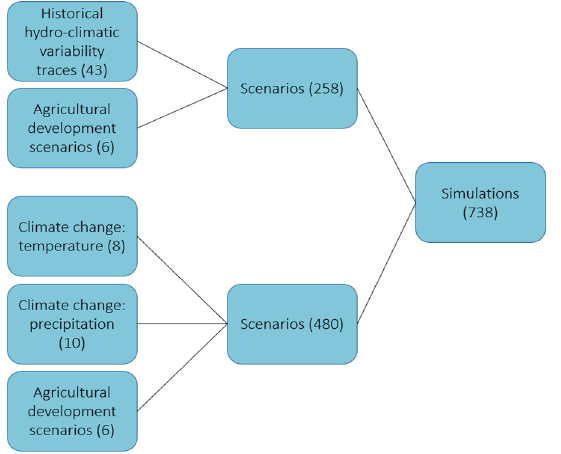
Figure 3. Schematic of scenario combinations.